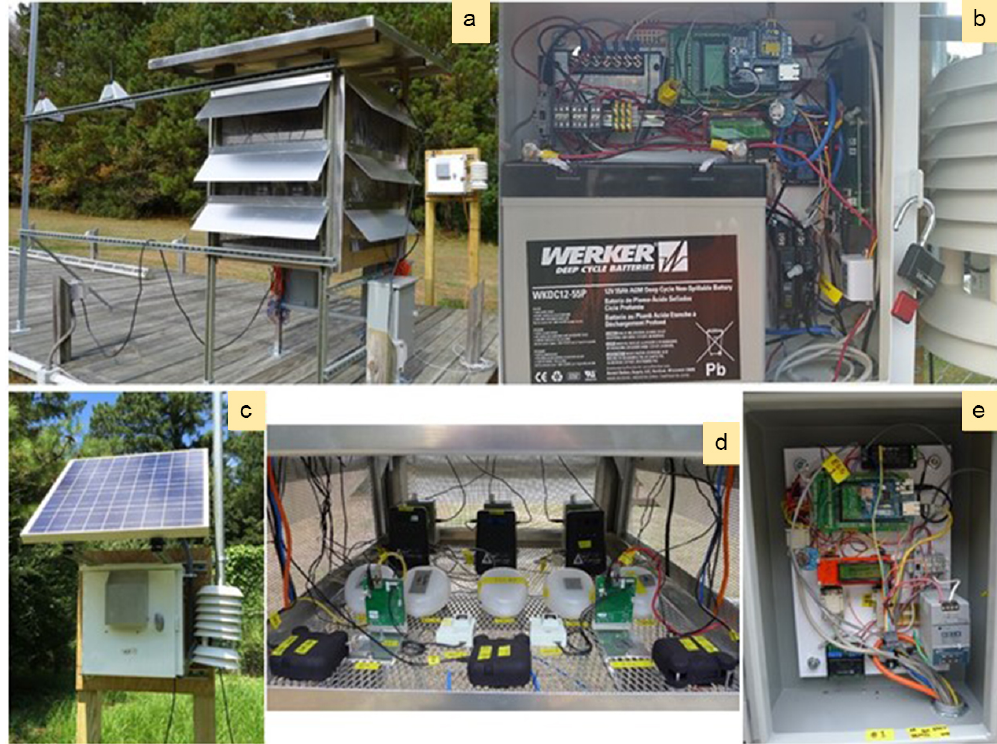
Figure 1. CAIRSENSE field equipment, including (a) SAFT instrument enclosure, ( b and c ) solar-powered WSN node, (d) interior of SAFT instrument shelter, and (e) WSN node utilizing 120V (nominal) AC